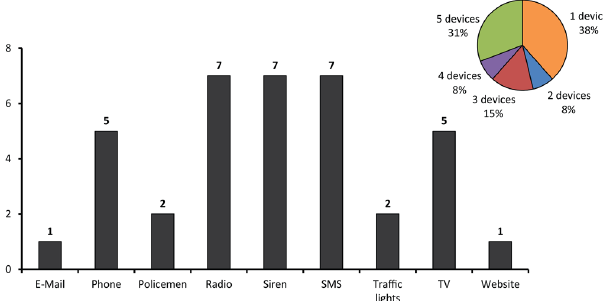
Fig. 14. Inventory of the different ways used to issue the alerts to local populations and percentage of number of communication de- vices coupled for the 13 reported answers got from questionnaires. The total number of communication vectors for alerts is over 13, because 38% of the systems use more than one type of